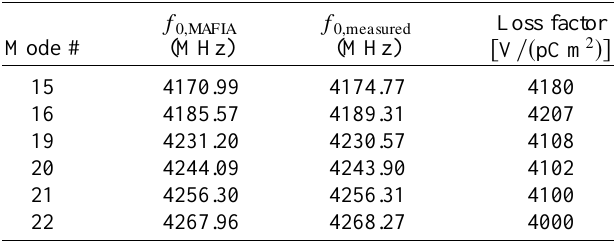
TABLE II. Loss parameter of trapped modes.